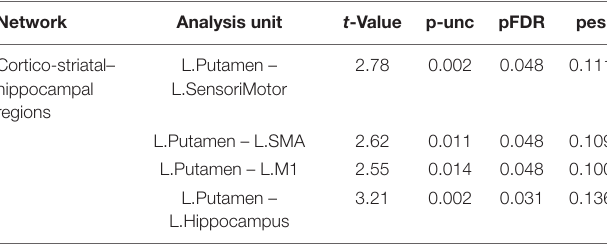
TABLE 1 | Region of interest-to-region of interest effects of [(YN–YNN) > (ON–ONN)] in the (RS3–RS2)